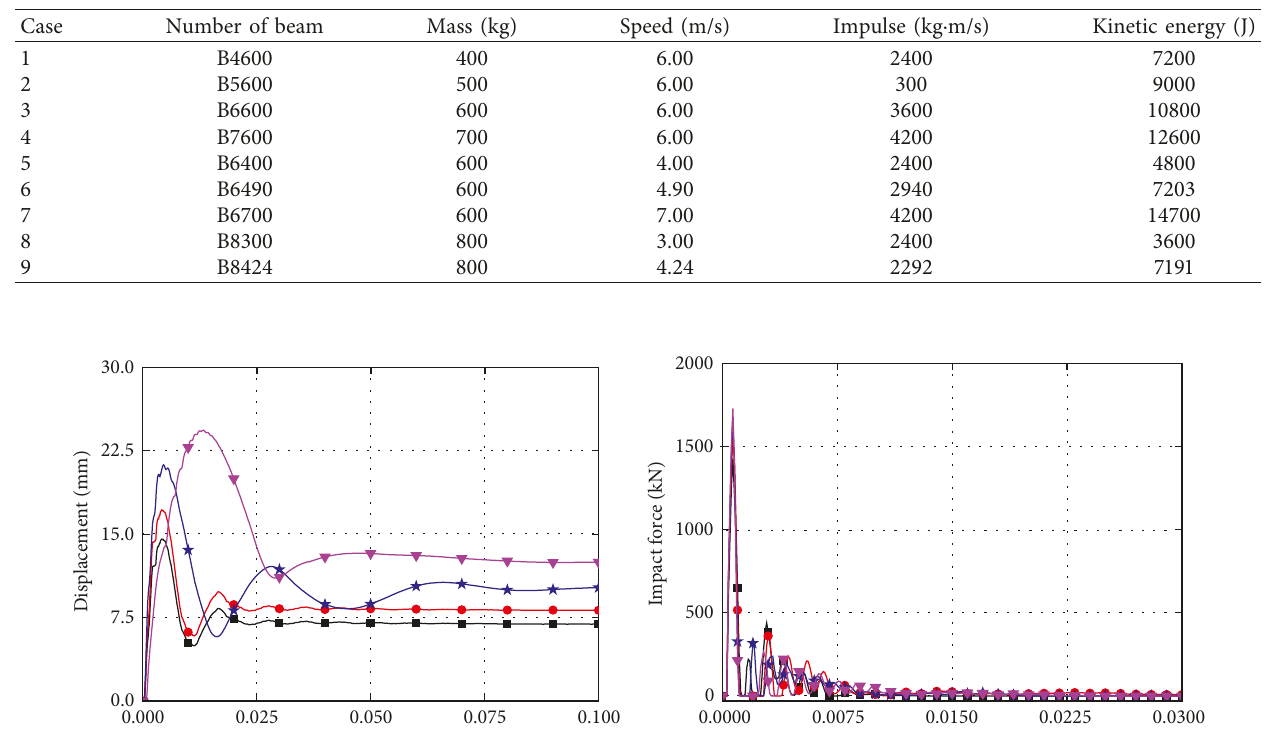
Table 9: Combination of mass and speed of falling weight.